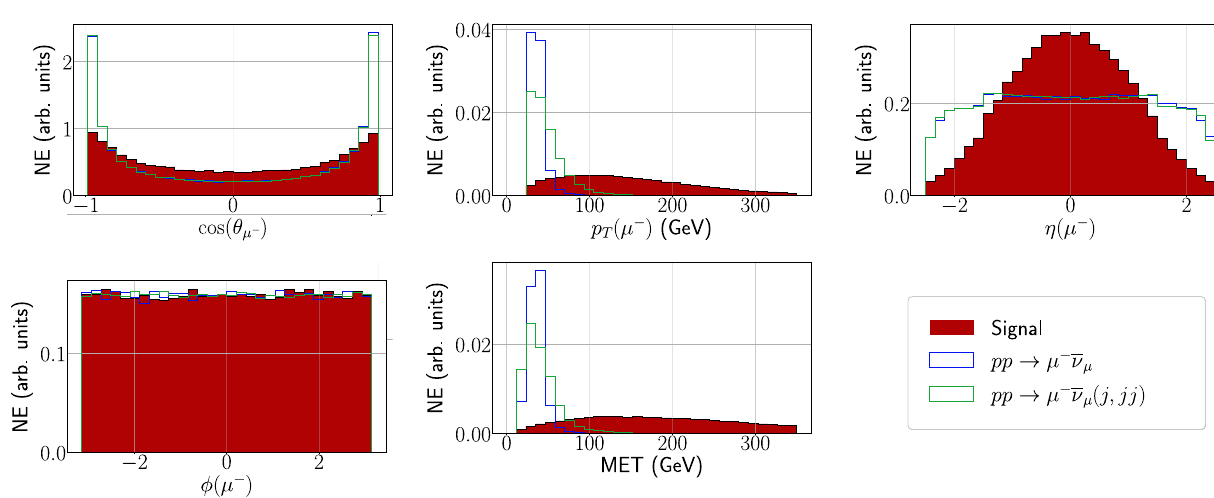
Fig. 11 Kinematic variables that the neural network uses for clas- sification. Data is simulated for a doublet VLL with mass of 700 GeV and in the ATLAS detector. From left to right and top to bottom, the variables are cos (θ μ − ) , transverse momentum of the